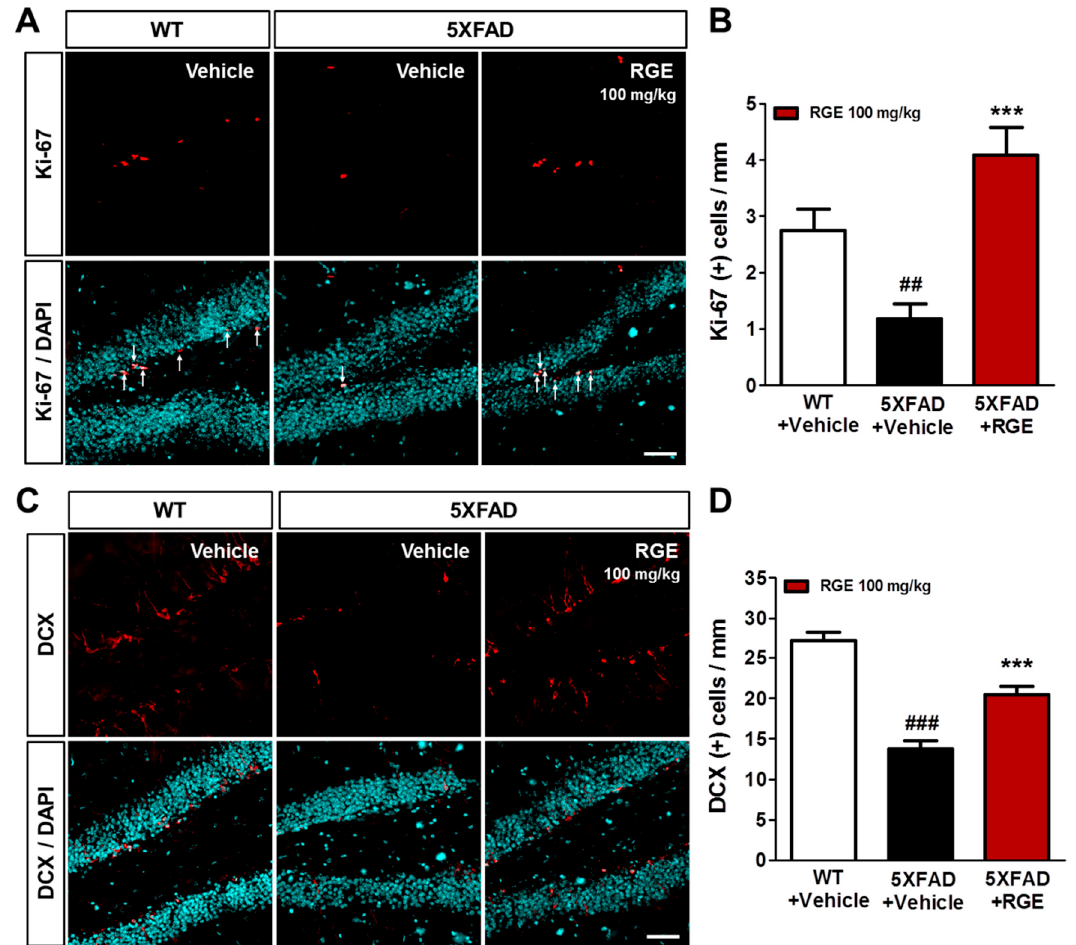
Figure 5. Effects of RGE on adult hippocampal neurogenesis in 5XFAD mice. ( A ) Immunofluorescent staining was performed in the subgranular zone (SGZ) of the dentate gyrus (DG) by using Ki-67, a marker of proliferation. White arrows indicate Ki-67 ( + ) cells (scale bar = 50 µ m). ( B ) The number of Ki-67 ( + ) cells per area was significantly reduced in 5XFAD mice compared to that in WT mice and significantly increased by RGE administration. ( C ) Immunofluorescent staining was performed in the SGZ of DG by using doublecortin (DCX), a marker of neuronal precursors (scale bar = 50 µ m). ( D ) The number of DCX ( + ) cells per area was significantly reduced in 5XFAD mice compared to that in WT mice and significantly increased by RGE administration. Data are presented as mean ± SEM. *** p < 0.001: vehicle-treated WT mice (white bar) versus vehicle-treated 5XFAD mice (gray bar). ## p < 0.01 and ### p < 0.001: vehicle-treated 5XFAD mice versus A β + RGE-treated 5XFAD mice (black bar).